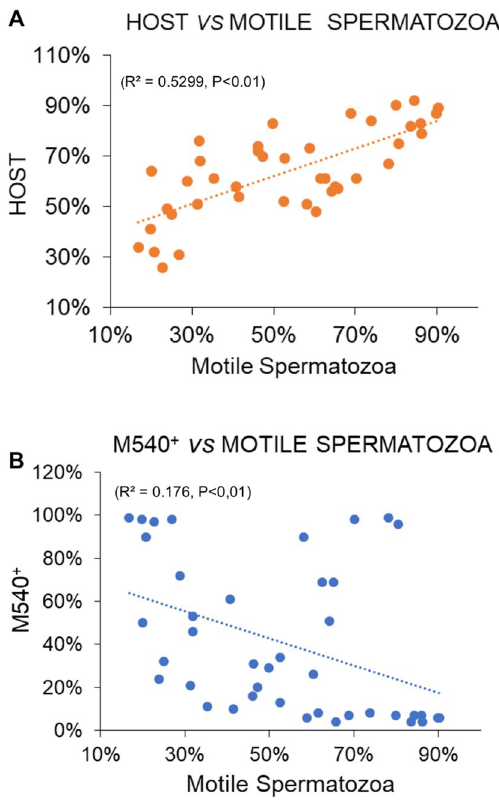
Figure 8. Correlation between human sperm motility and plasma membrane integrity and organization. ( A ) Positive correlation between the functional integrity of sperm plasma membrane evaluated by HOS test and the percentage of motile spermatozoa. ( B ) Negative correlation between the lipid disorganization (M540 + spermatozoa) and the percentage of motile spermatozoa. Human spermatozoa were incubated 1 h in BWW at 37 °C, 5% CO 2 , in the absence or the presence of RUP, GLY, or POEA, as described in Material and Methods. Values were result of 7 independent experiments (n = 41) in each correlation. The resultants Pearson coefficients are statistically significant for the positive correlation ( A ) and the negative correlation ( B ), r = 0.728 and − 0.410 respectively (P <